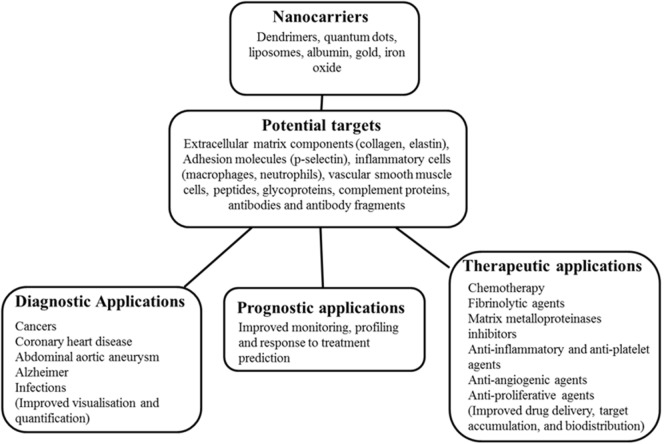
Schematic diagram of nanocarriers, potential targets, and potential applications in medicine. This shows nanocarriers with typical nanoparticle (NP) base/core, potential targets in humans ranging from receptors, immune fragments, and vascular tissue components. The potential role of the NPs in disease management in medicine is also highlighted.